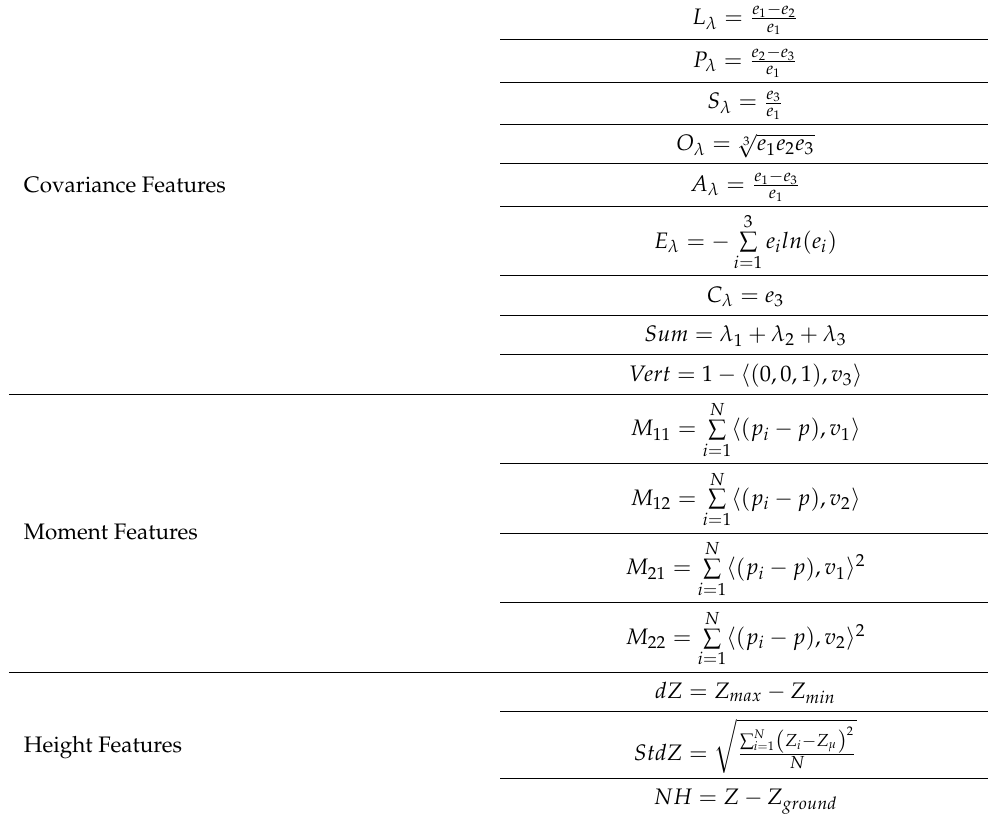
Table 1. Covariance, moment, height, and verticality LiDAR point